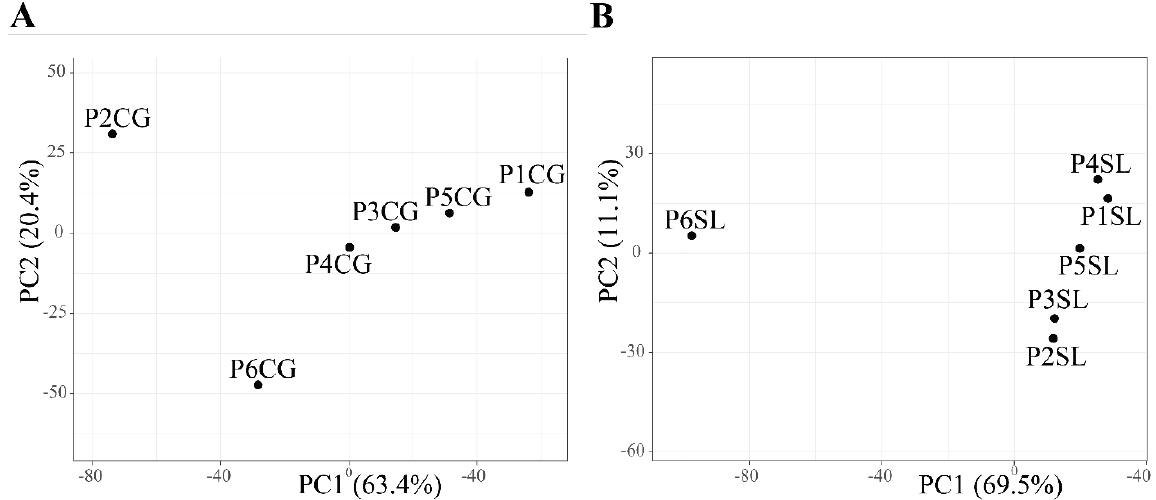
Figure 4. Principal component analysis of obtained bacterial OTUs present in the roots of ( A ) C. gigantea and ( B ) S. littoreus . Abbreviations of sampled populations: P — Population (Population 1 to 6, P1 to P6), CG — C. gigantea , SL — S. littoreus .